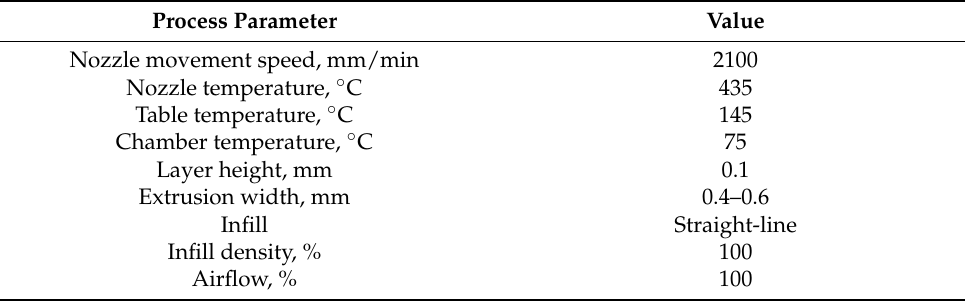
Table 1. Manufacturing parameters.